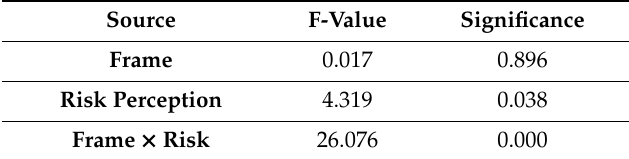
Table 7. Results of ANOVA (frame and risk perception).